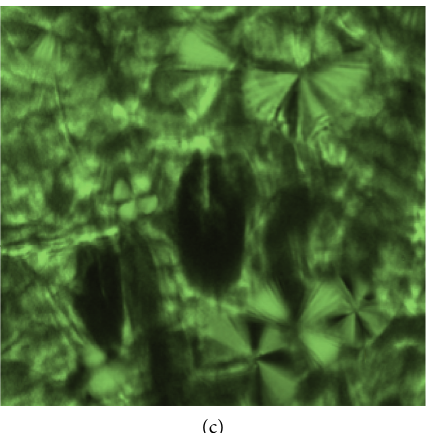
Figure 9: Optical photomicrographs of (a) compound 5a (80 ° C, 40x), (b) compound 5b (89 ° C, 10x), and (c) compound 5c (75 ° C, 10x) showing mesophase textures.